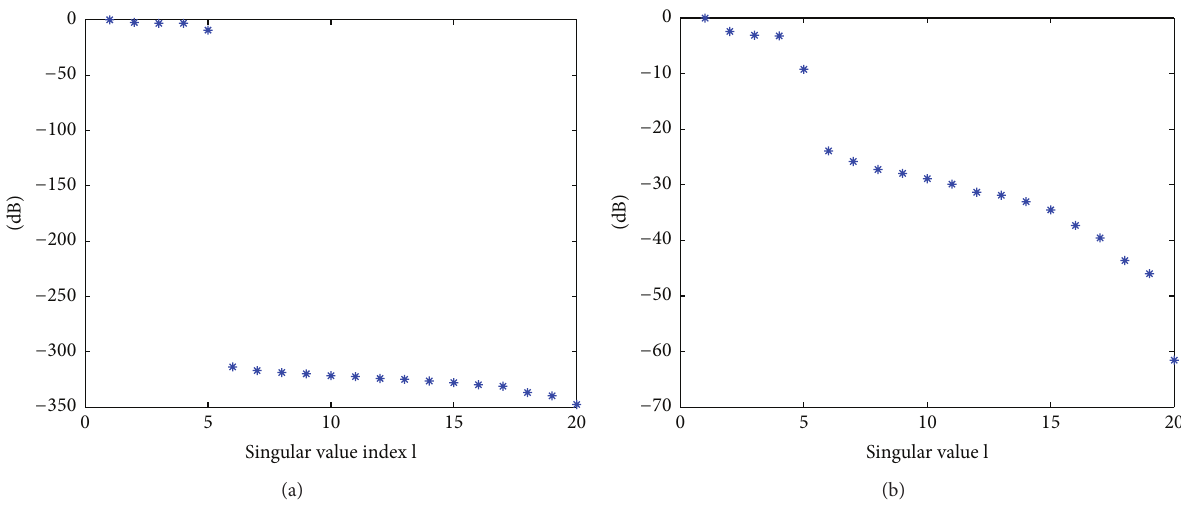
Figure 3: Singular value behaviour: (a) in absence of noise on data, (b) in presence of noise on data.